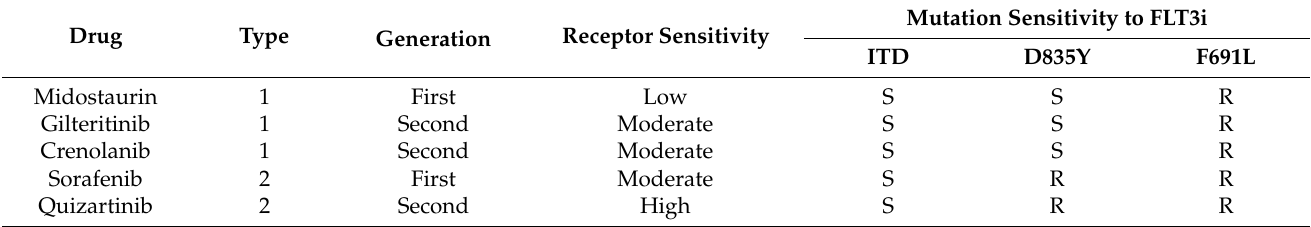
Table 1. Characteristics of FLT3